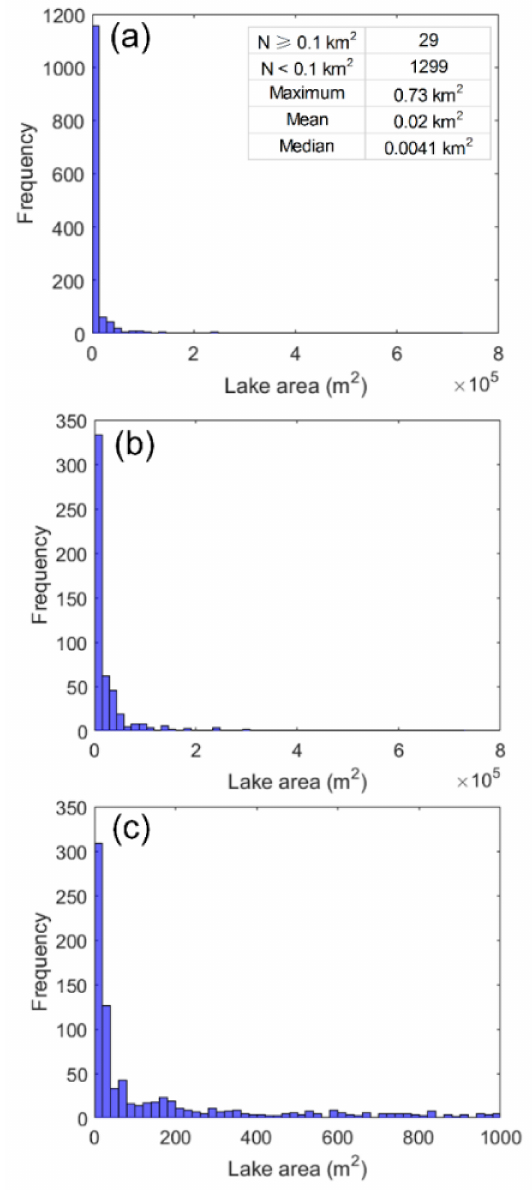
Figure 7. Histogram of glacial lake area for the study area: area distribution for ( a ) All lakes, ( b ) Lakes larger than 1.0 × 10 3 m 2 , and ( c ) Lakes smaller than 1.0 × 10 3 m 2